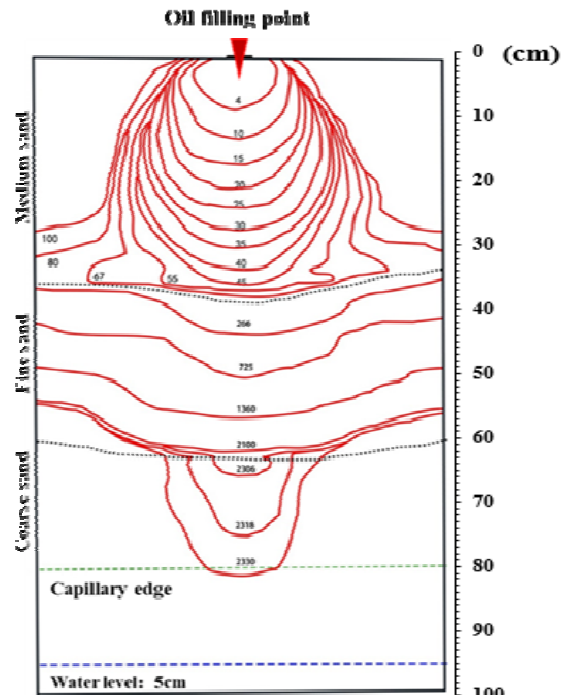
Figure 4. Distribution of the LNAPL infiltration front at different times in the M-F-C tank. Capillary forces played an important role in the case of multi-phase fluid flow in layered heterogeneous systems. Fine sand had a higher entry pressure than medium sand because its permeability was less than that of medium sand; consequently, if the LNAPL entered a fine sand layer, the capillary pressure needed to reach a higher level. Prior to entry, the LNAPL accumulated and spread above the interface between medium and fine